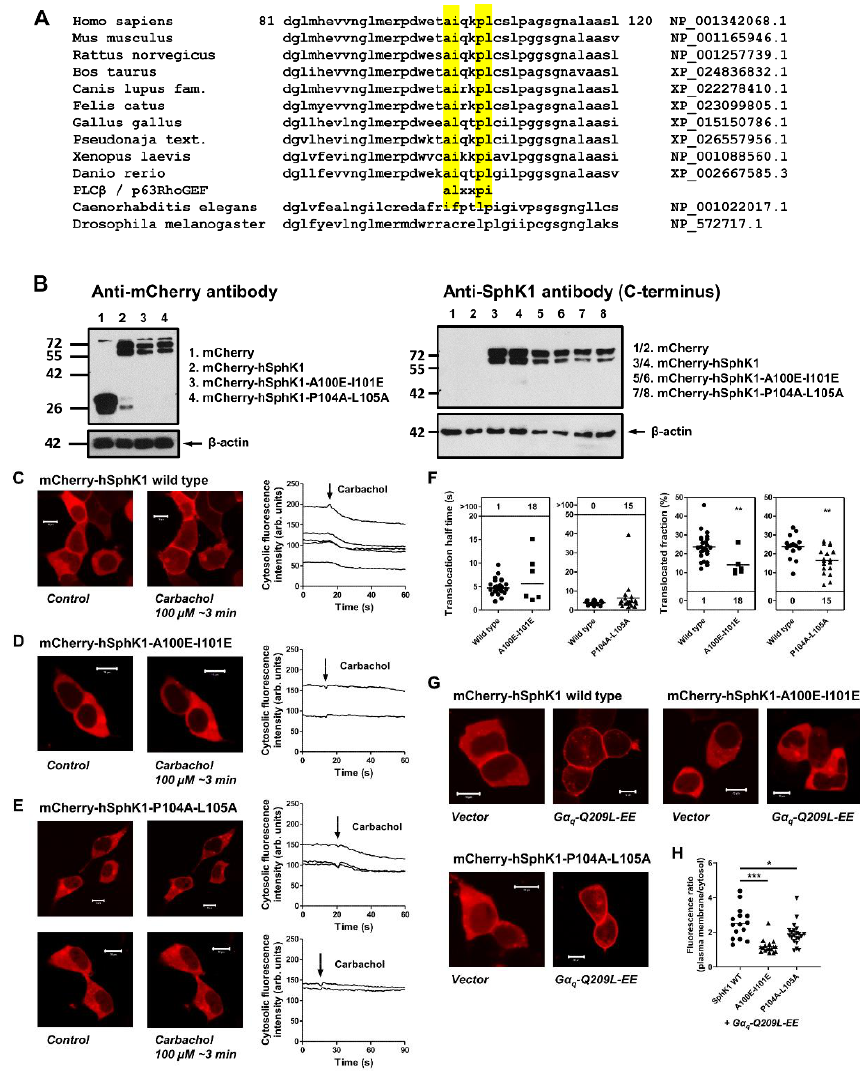
Figure 6. Identification of structural elements in SphK1 required for G q/11 -mediated translocation. ( A ) Sequence alignment of diverse SphK1 homologues between amino acids 81–120 of human SphK1. ( B